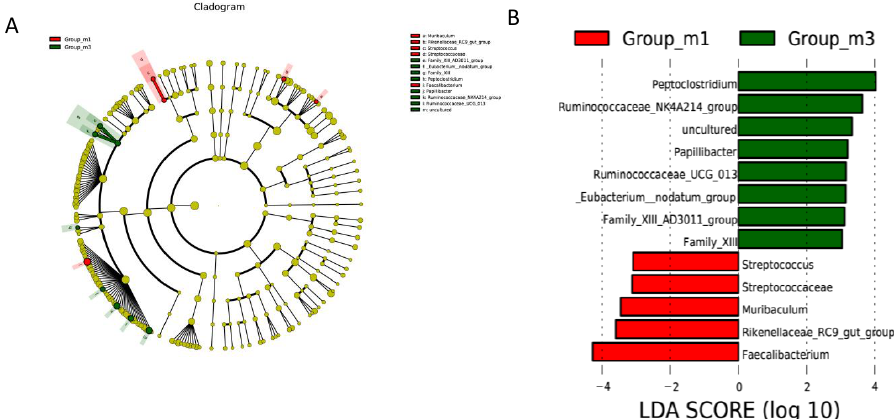
Figure 3. The taxonomic cladogram ( A ) and the LDA (linear discriminant analysis) score ( B ) obtained from linear discriminant analysis e ff ect size (LEfSe) analysis of the gut microbiota in di ff erent groups. m1, control. m3, E. faecium